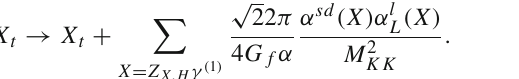
as they involved muons with higher degree of compositeness.